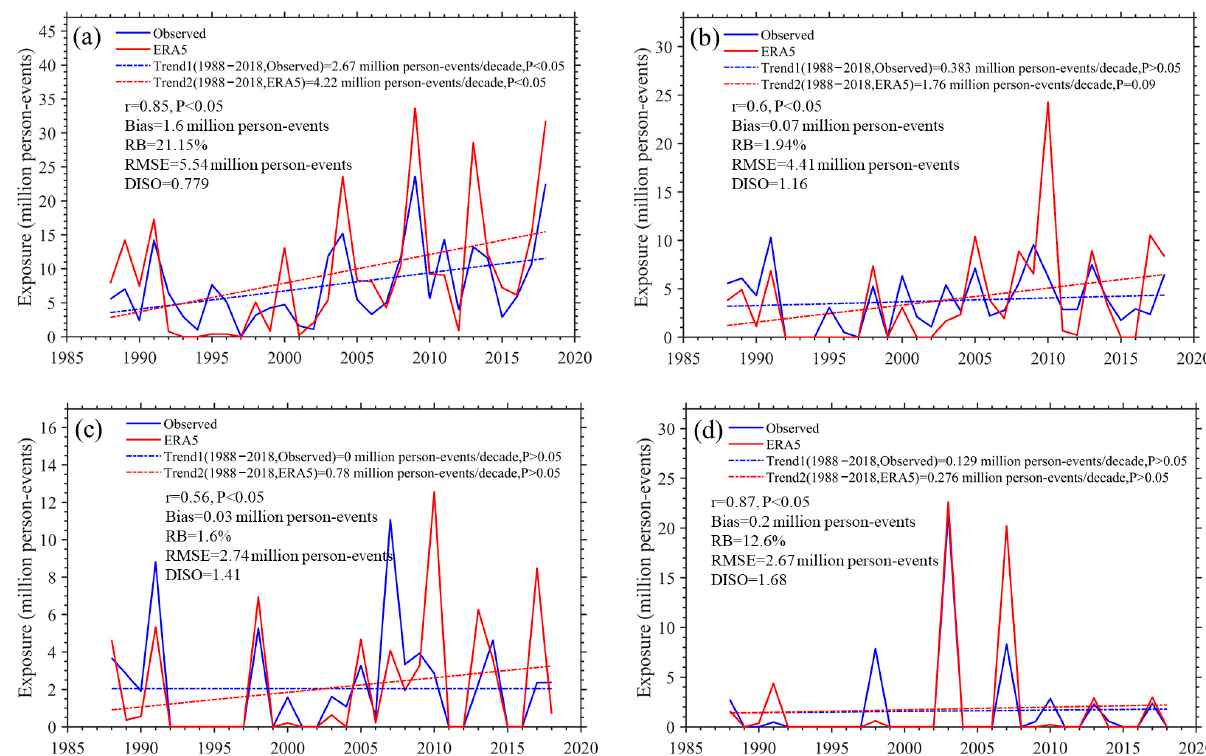
Figure 12. Variations of annual population exposure to ( a ) moderate, ( b ) severe, ( c ) extreme, and ( d ) exceptional CDHW frequencies from 1988 to 2018 in the GRB.